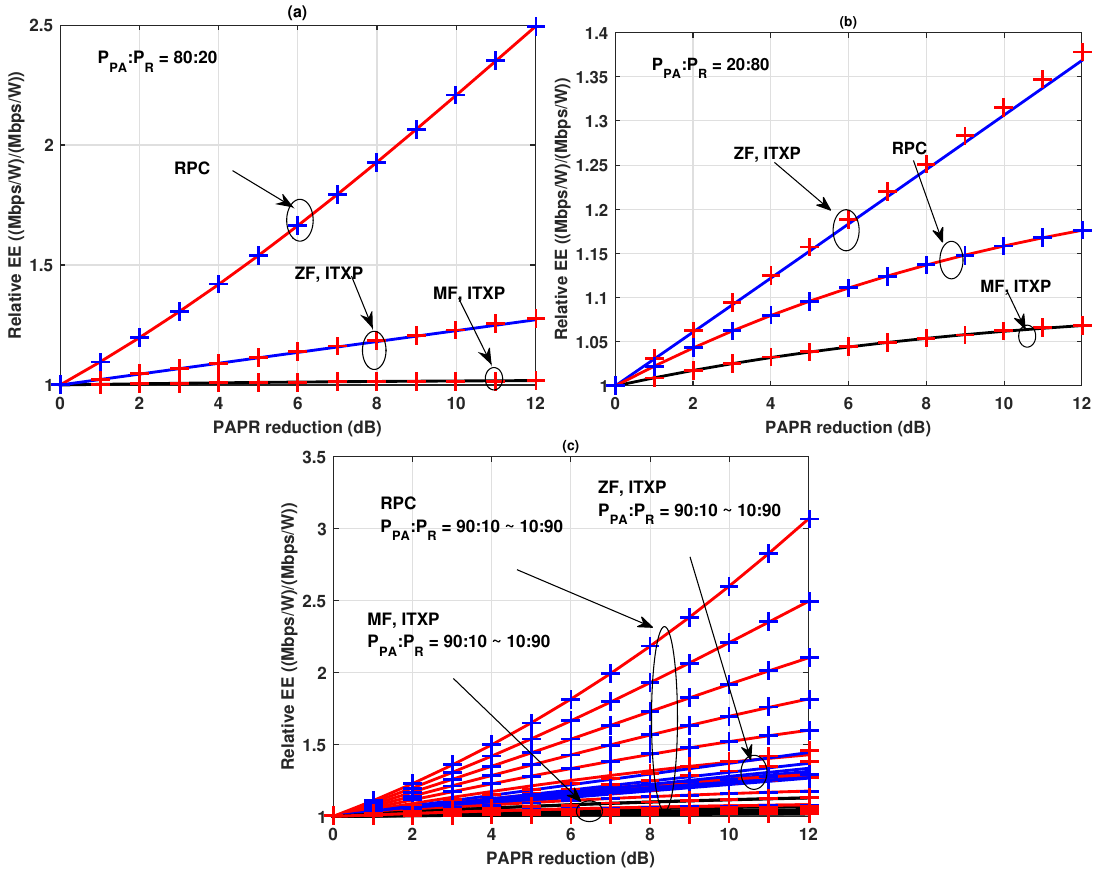
Figure 4. Relative EE versus PAPR reduction (dB), when N t = 400, K = 40; ( a ) P PA : P R = 80:20; ( b ) P PA : P R = 20:80; ( c ) P PA : P R = 90:10~10:90. Solid lines represent the results of analysis (Equations (19) and (20)), and red/blue marks of ’+’s indicate the results of